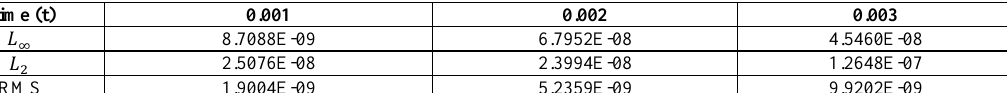
Table 4. Various error norms for Example 2